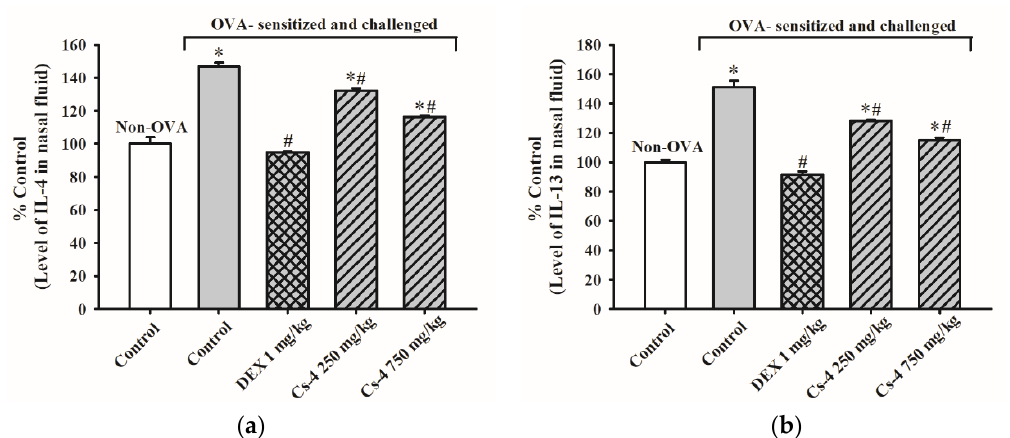
Figure 3. The effect of Cs-4 on ( a ) the levels of interleukin (IL)-4 and ( b ) IL-13 in the NLF of OVA-sensitized and challenged mice. Each bar represents the mean ± S.E.M., with n = 5. * Significantly different from the non-OVA control group. # Significantly different from the OVA-sensitized and challenged control group.